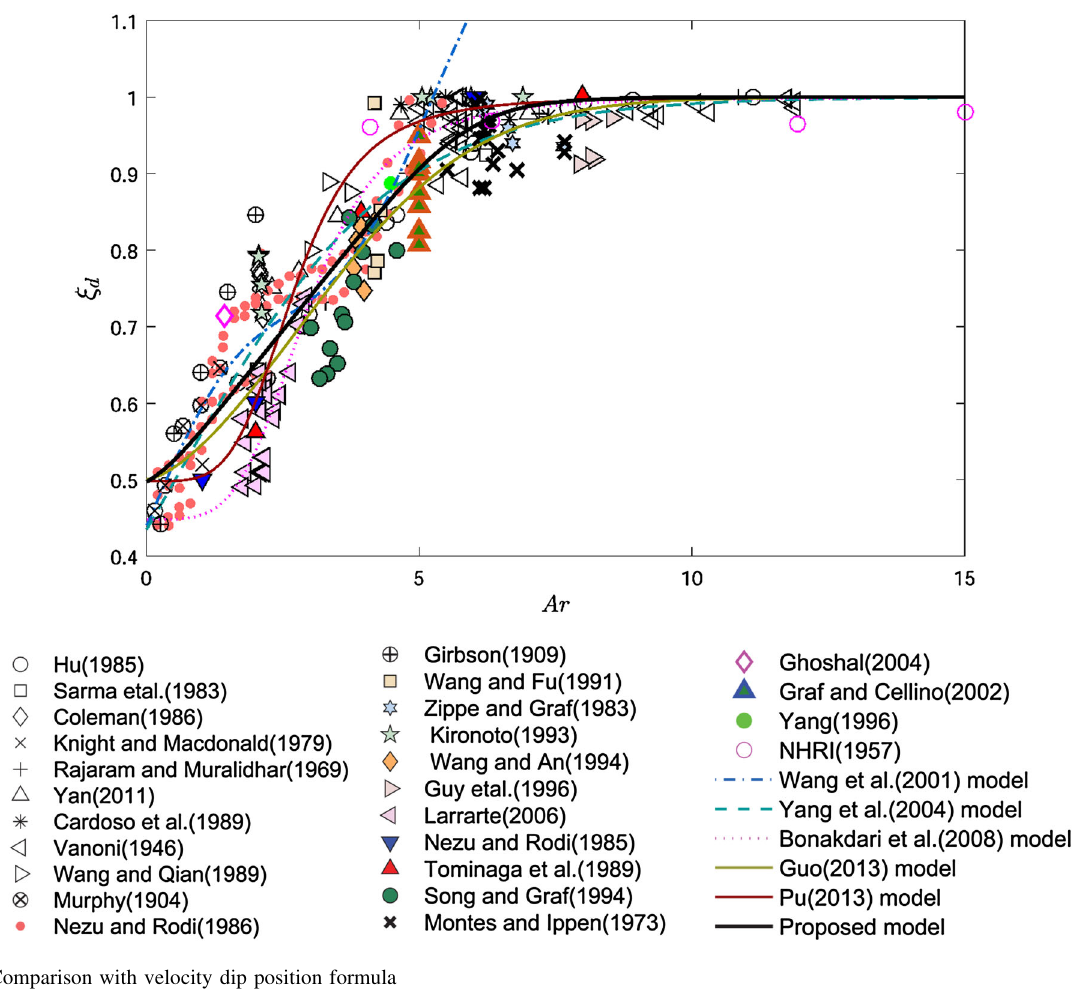
Fig. 4 Comparison with velocity dip position